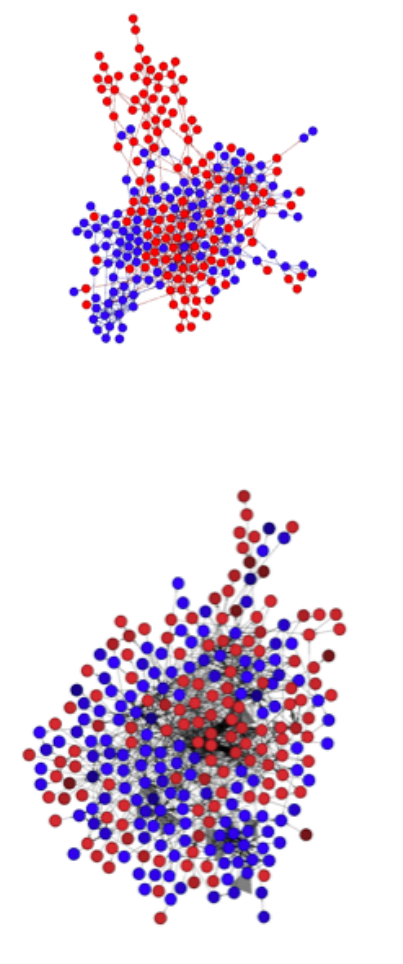
Figure 4. Network graphs according to four connection types (from top left, clockwise): Contacts, Favorites, Tags, Comments.